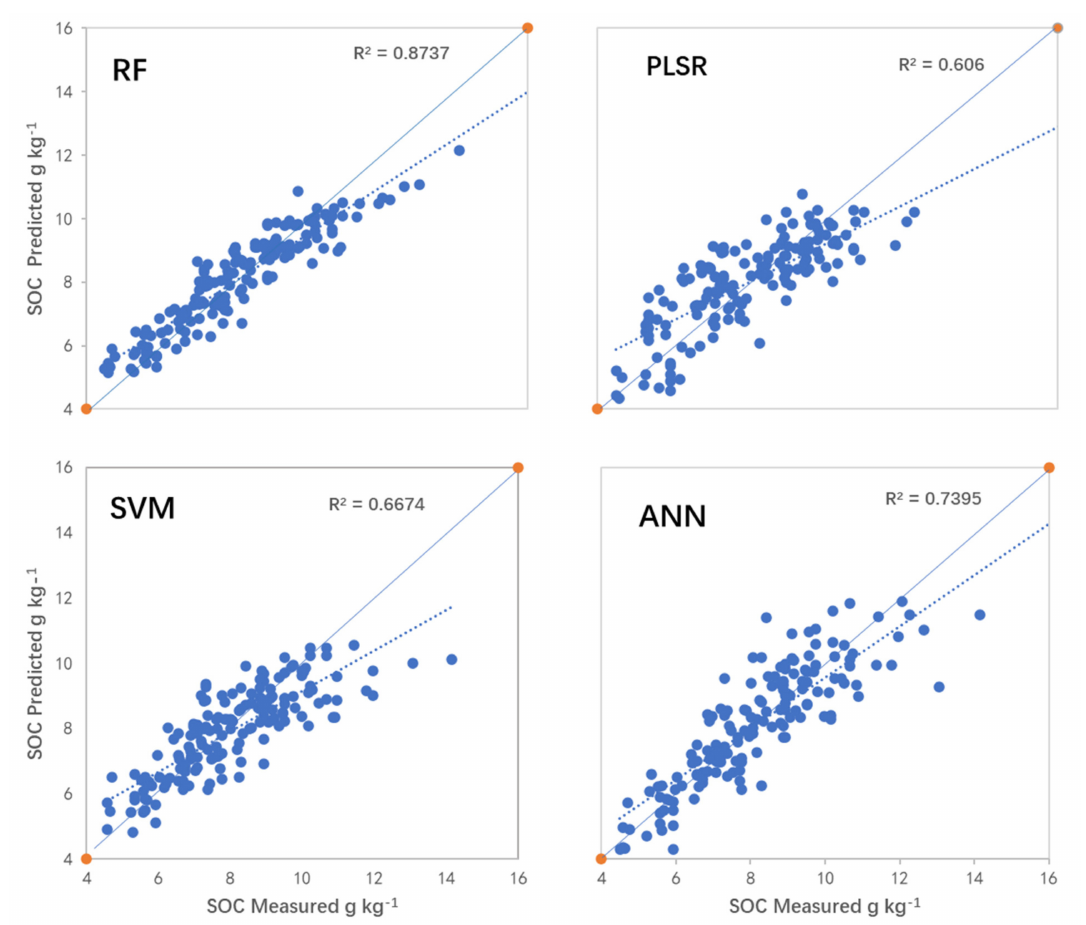
Figure 5. Predicted versus observed soil organic carbon (SOC) for the calibration dataset using four different models over the western Guanzhong Plain, China. RF = random forest; PLSR = partial least squares regression; SVM = support vector machine; ANN = artificial neural